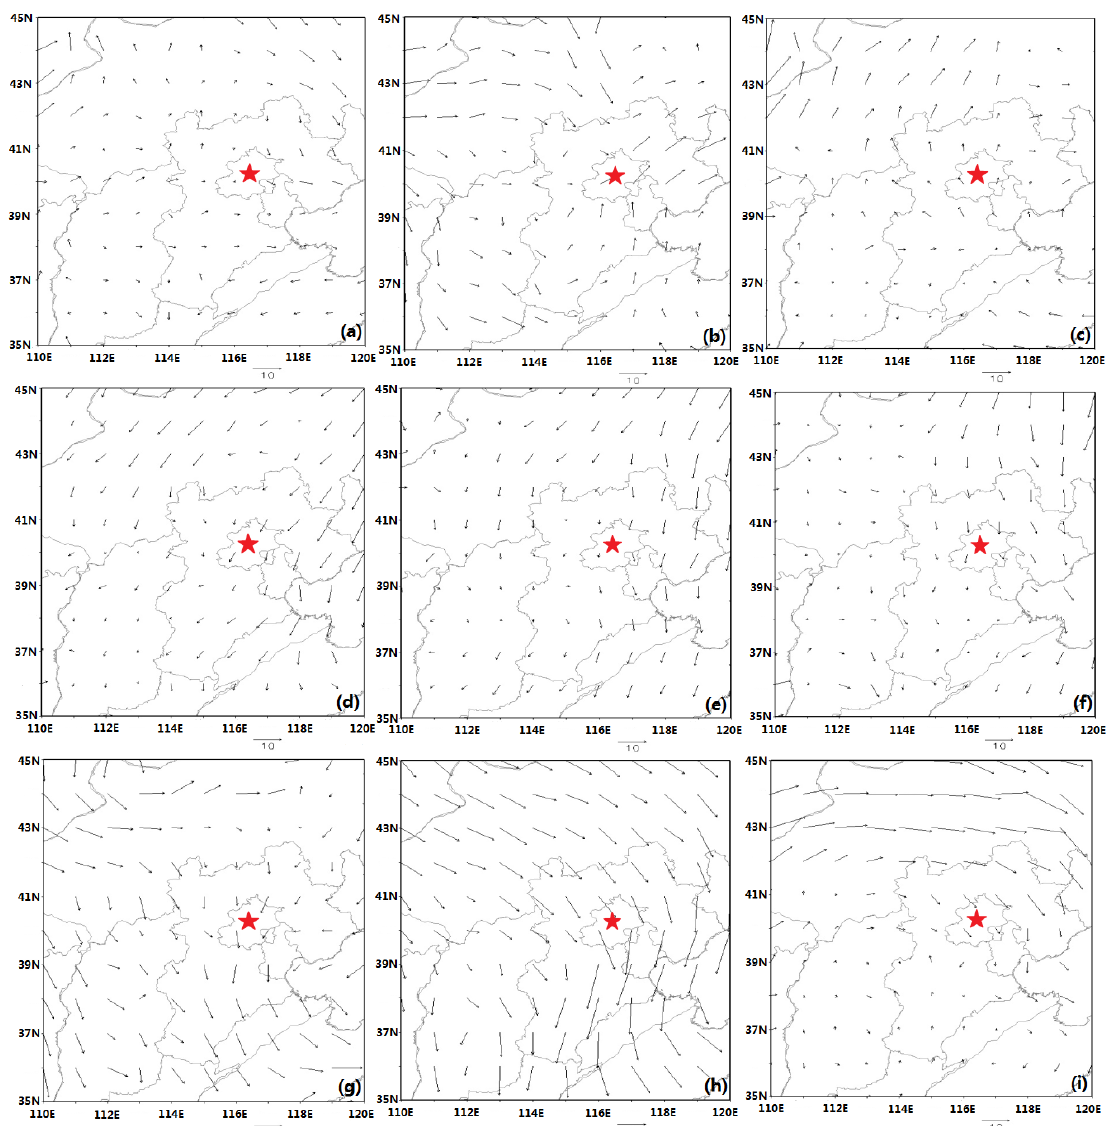
Figure 10. Wind field at 850 hPa at 08:00 ( a – c ) on 16–18 August; 14:00 ( d – f ) on 26–28 August; and 08:00 ( g – i ) on 11–13 September in the Beijing area. The red star represents the Beijing measurement site.